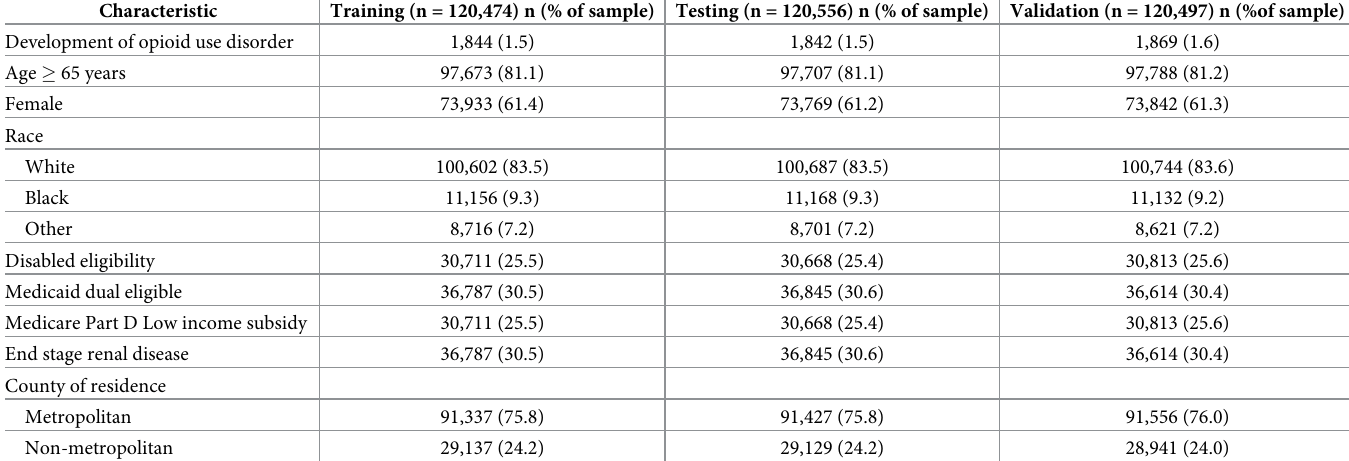
Table 1. Development of opioid use disorder and sociodemographic characteristics among Medicare beneficiaries (n = 361,527), divided into training, testing, and validation samples. Characteristic